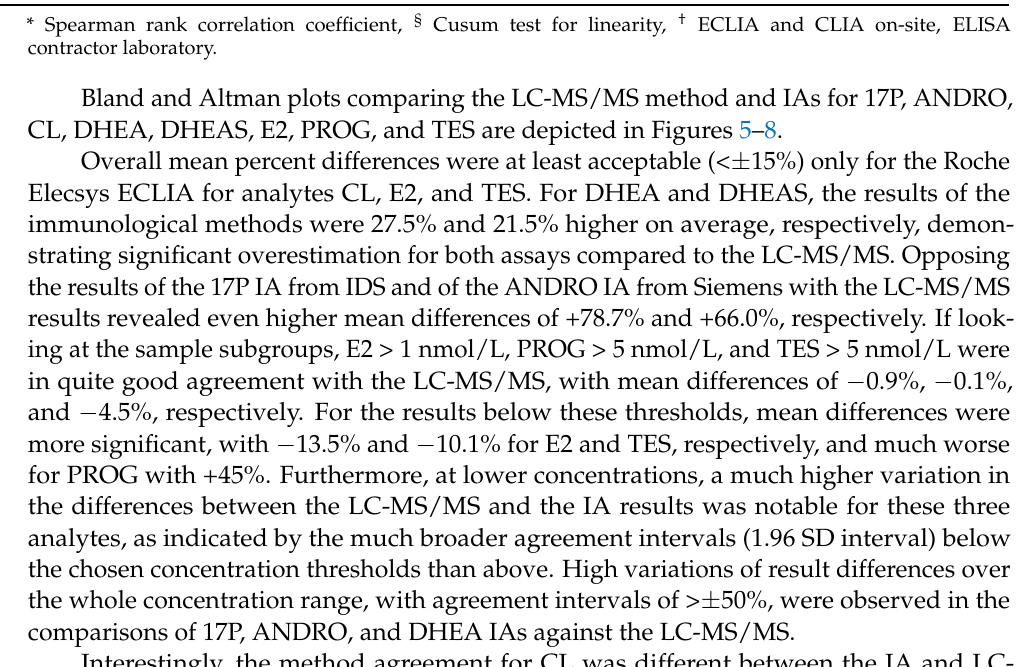
* Spearman rank correlation coefficient, § Cusum test for linearity, † ECLIA and CLIA on-site, ELISA contractor